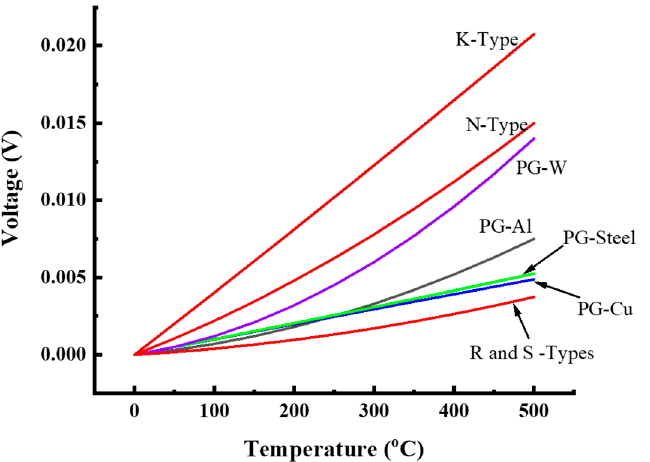
Figure 6. Voltage-temperature plots comparing the custom-designed thermocouples to the commercial K, N, R, and S-types. The commercial TCs are colored “red” for distinction. With the exception of the K-type, the N-type compares favorably with the PG-W which is the best performing TC among the custom TCs. Data for the commercial TCs are from [40]. Table 2. Summary of Seebeck coefficients under heating and cooling cycles in relation to the thermal and electrical prop- erties of the thermoelements [28,34,41].